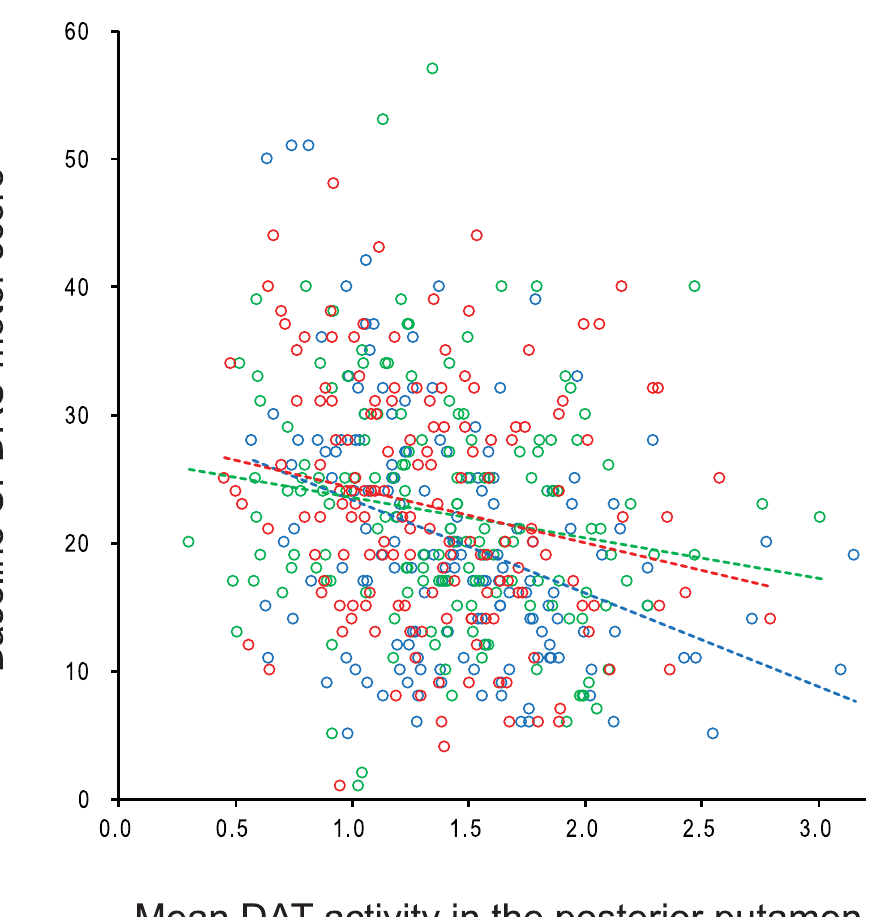
Fig 1. A scatterplot showing baseline UPDRS-motor scores and mean DAT binding in the posterior putamen. High-tertile group (red circles and line) showed higher UPDRS-motor scores at similar DAT binding levels in the posterior putamen than low-tertile group (blue circles and line). Middle-tertile group (green circles and line) showed similar UPDRS-motor scores to high-tertile group. UPDRS-motor, Part III of the Unified Parkinson’s Disease Rating Scale; DAT, dopamine